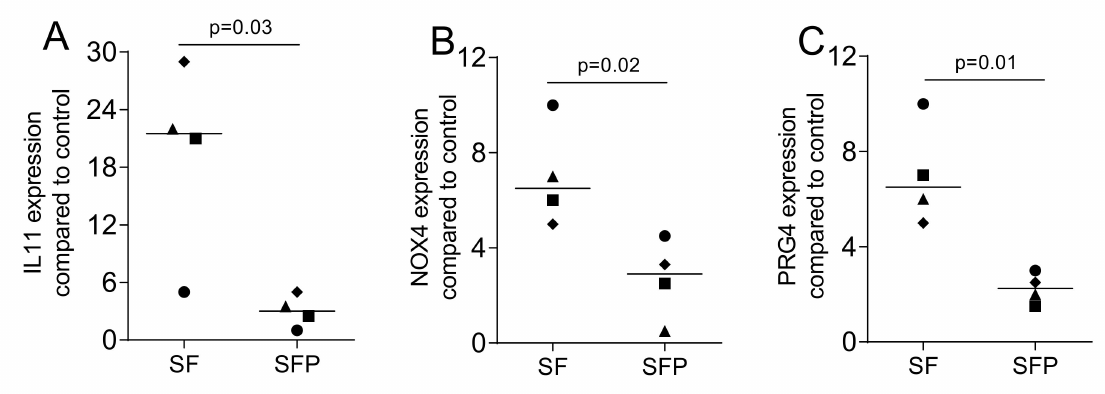
Figure 7. Protease inhibitors lower the TGF- β activity in the supernatant of OraGRAFT ® Prime. Gingival fibroblasts were exposed to aqueous supernatants of OraGRAFT ® Prime in the absence (SF) or presence (SFP) of the protease inhibitors. The expression of ( A ) IL11, ( B ) NOX4, and ( C ) PRG4 was decreased significantly by protease inhibitors. The expression of IL11, NOX4, and PRG4 was measured by quantitative RT-PCR. N = 4. Statistic is a paired t